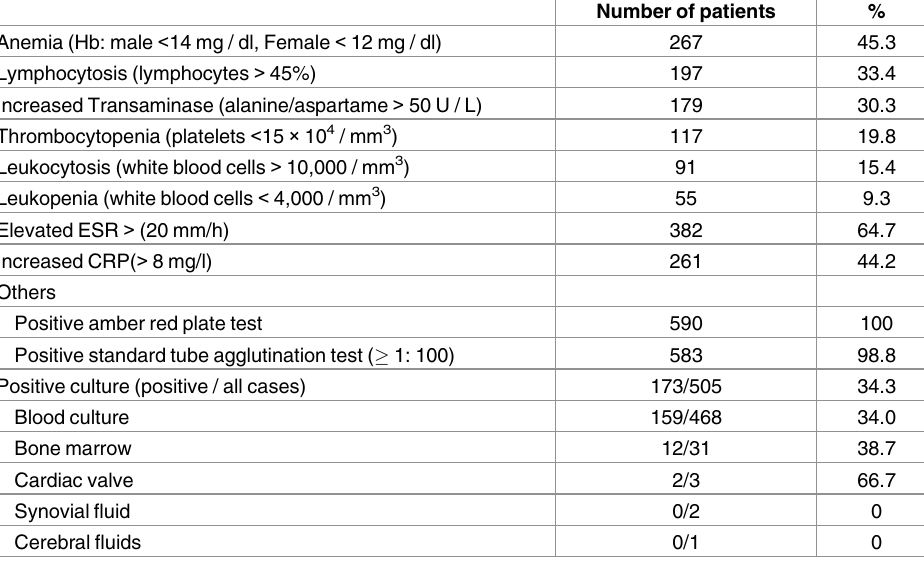
Table 3. Laboratory results of patients with